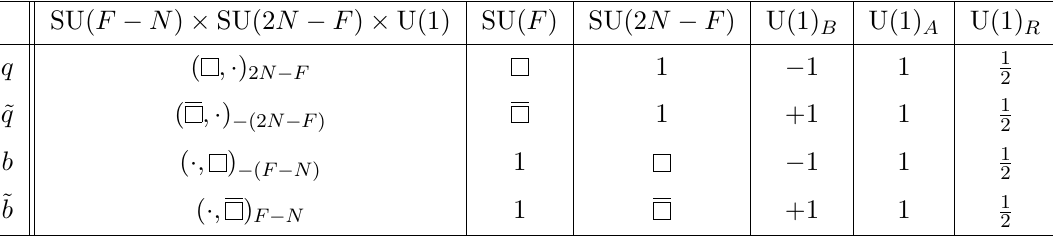
Table 6 . The putative magnetic dual to the 3d N = 4 SU( N ) gauge theory with F hypermultiplets. This table only shows the charge assignment of the fundamental hypermultiplets and omits the adjoint chiral superfields. The gauge group should be S (U( F − N ) × U(2 N − F ))